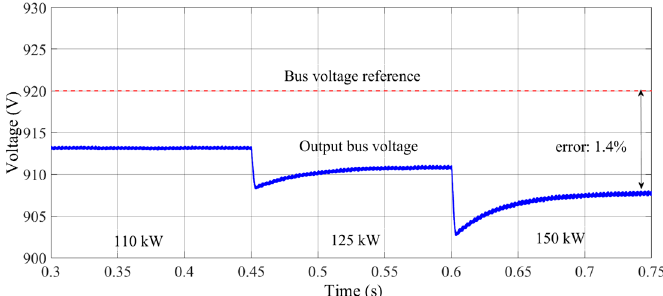
Figure 16. Output voltage V DC with 10% of tolerance value in passive devices and an increase of resistance in passive and active devices.